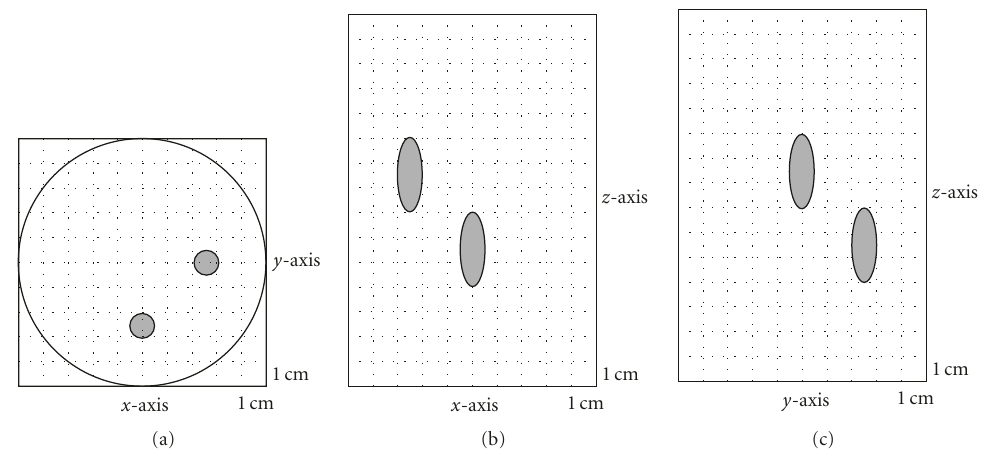
Figure 8: Physical setup for experiment 2. (a) ( x , y ) plane view, (b) ( x , z ) plane view, and (c) ( y , z ) plane view.